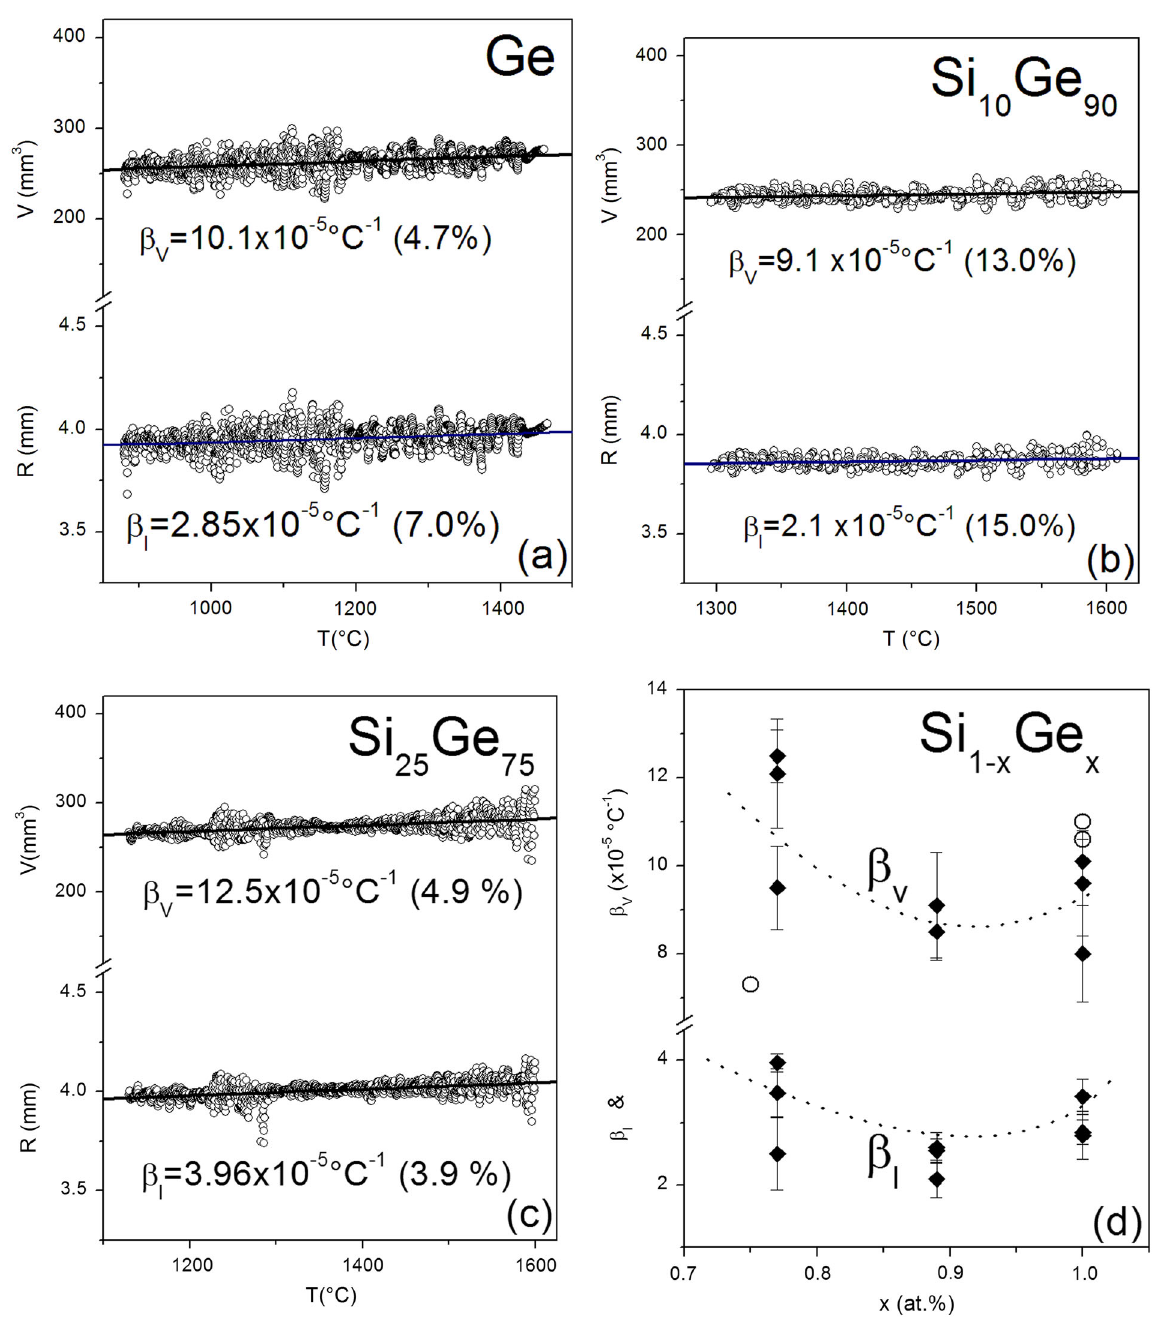
Fig. 2 Mean radii and volumes for Ge ( a ), Si 10 Ge 90 ( b ), and Si 25 Ge 75 ( c ) as a function of the temperature. The thermal expansion coef fi cients β v and β l ( d ) were determined by linear fi ts. The three additional data ( circles ) stem from refs